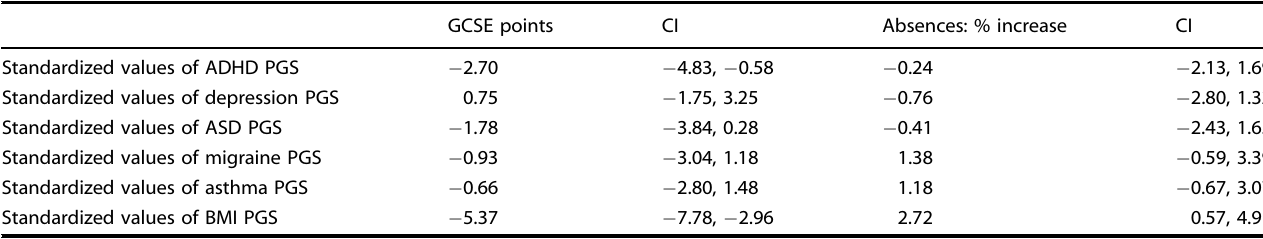
a N = 6113. Adjusted for gender and PC1 – PC20. GCSE points score: range 0 – 540, mean 332.3, SD 87.4. Coef fi cients for absences represent proportional change in absenteeism (0% = no change) per SD increase in the polygenic